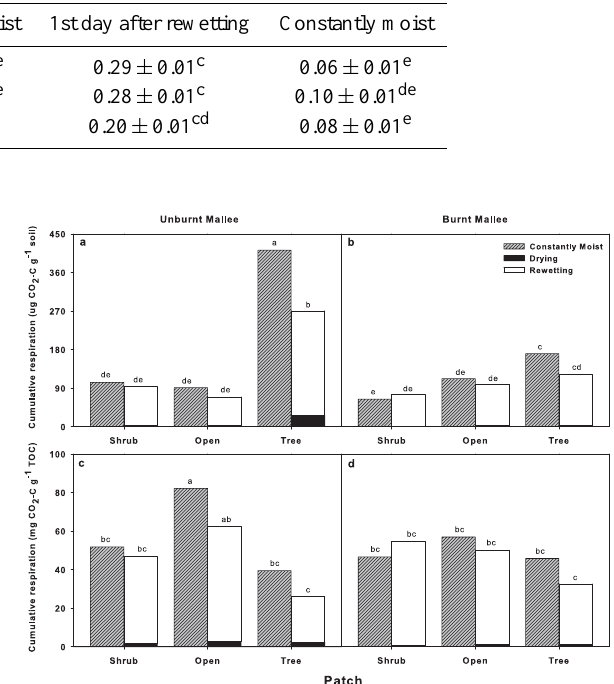
Figure 2. Cumulative respiration per gram of soil ( a and b ) and per gram of TOC ( c and d ) in constantly moist and drying–rewetting (9- day dry and 10-day moist) soils from unburnt ( a , c ) and burnt ( b , d ) mallee under shrubs, in open areas and under trees (mean, n =